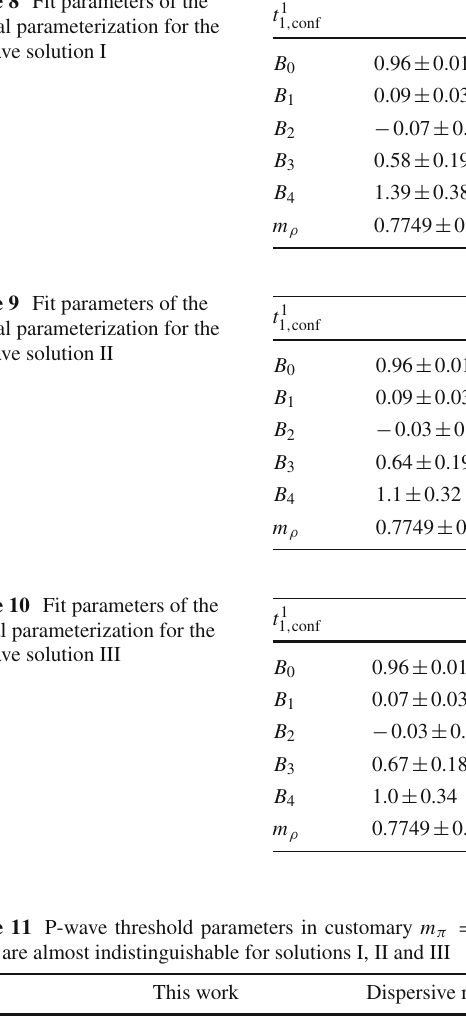
Table 8 Fit parameters of the Global parameterization for the P -wave solution I